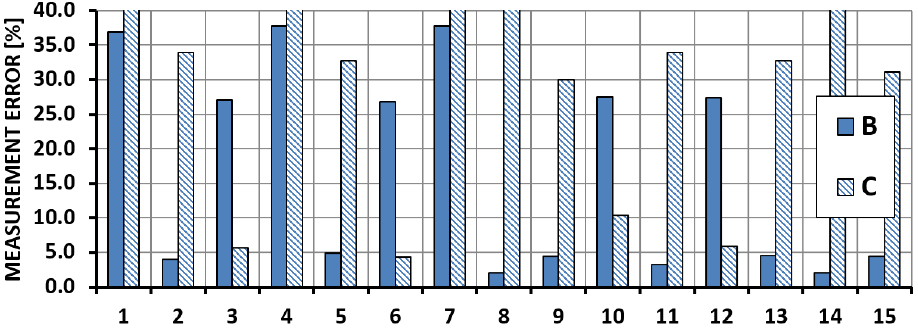
Figure 15. Shear force measurement error—OPT Section.